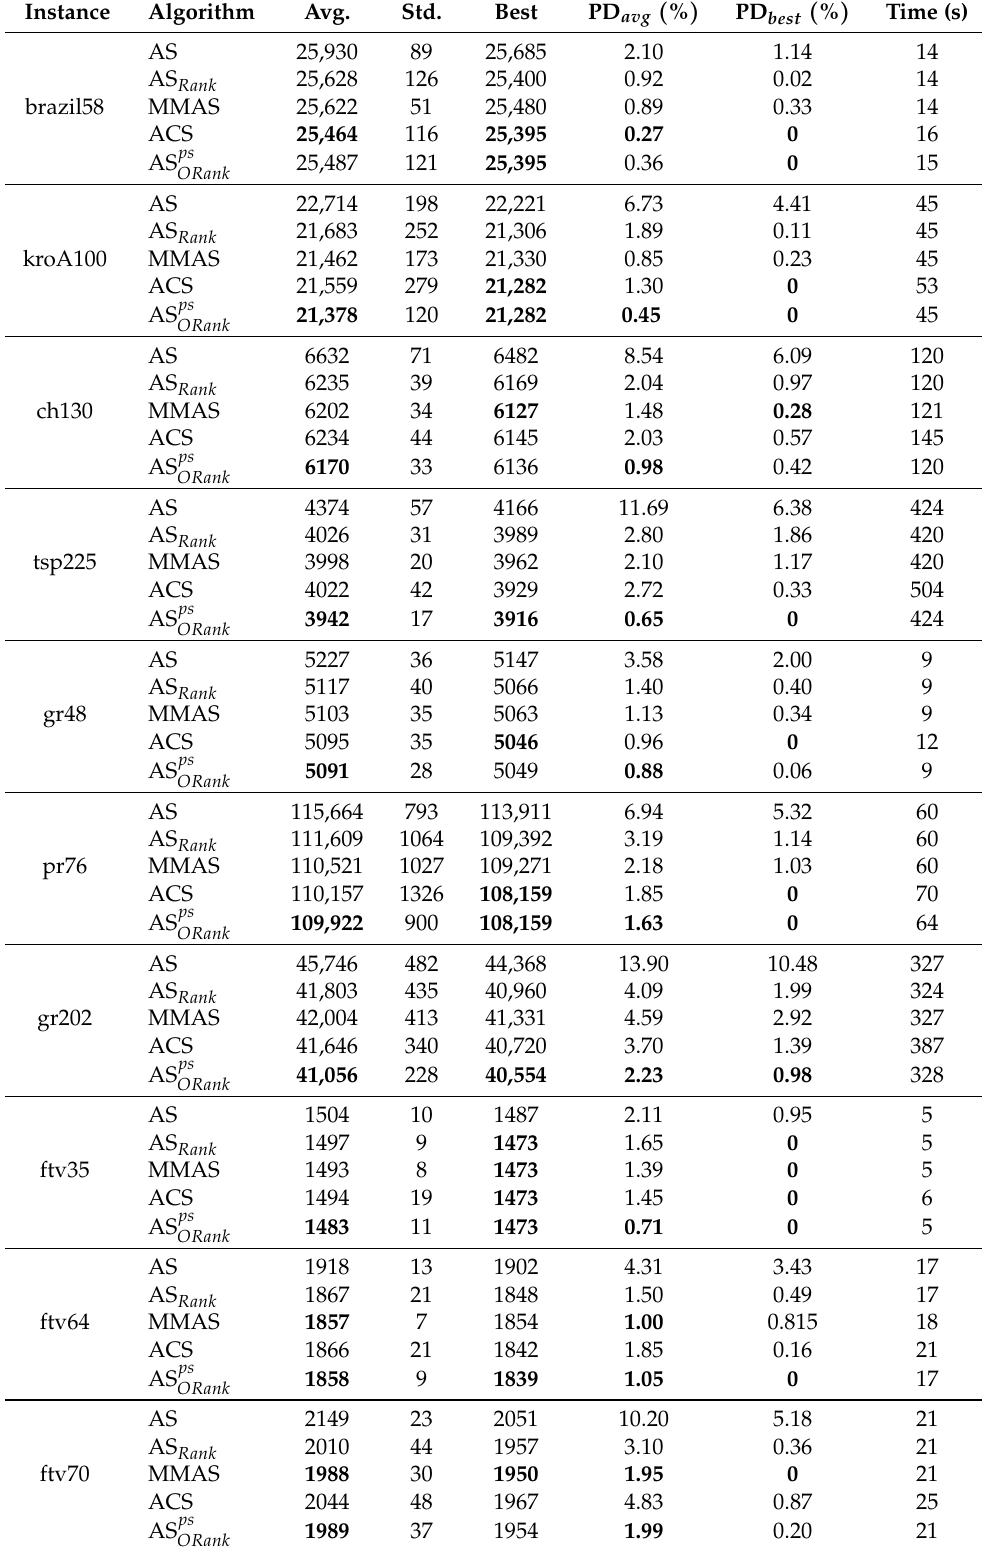
Table 5. Results for symmetric and asymmetric TSP instances obtained by ACO algorithms. The best results for each problem instance are highlighted in